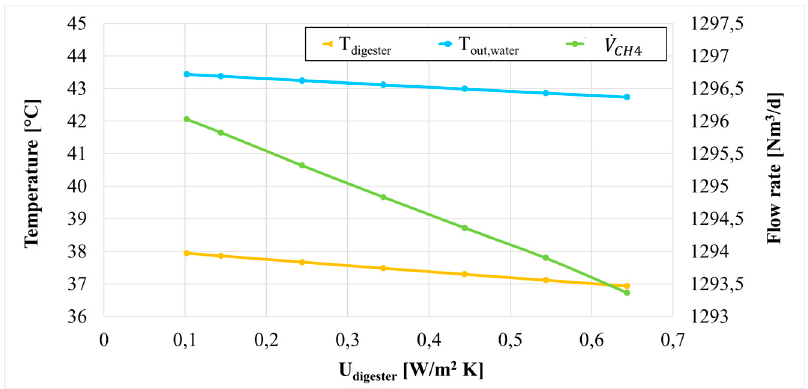
. Figure 8. T digester , T out,water , 𝑉(cid:4662) (cid:3004)(cid:3009)(cid:2872) vs U digester for OFMSW m & = 0.174 kg/s, water m & = 0.557 kg/s and T in,water = 55 °C . . V CH 4 vs. U digester for m OFMSW = 0.174 kg / s, m water = 0.557 kg / s and T in,water Figure 8. T digester , T out,water , = 55 ◦ C. Energies 2019 , 12 , x FOR PEER REVIEW 17 of 23